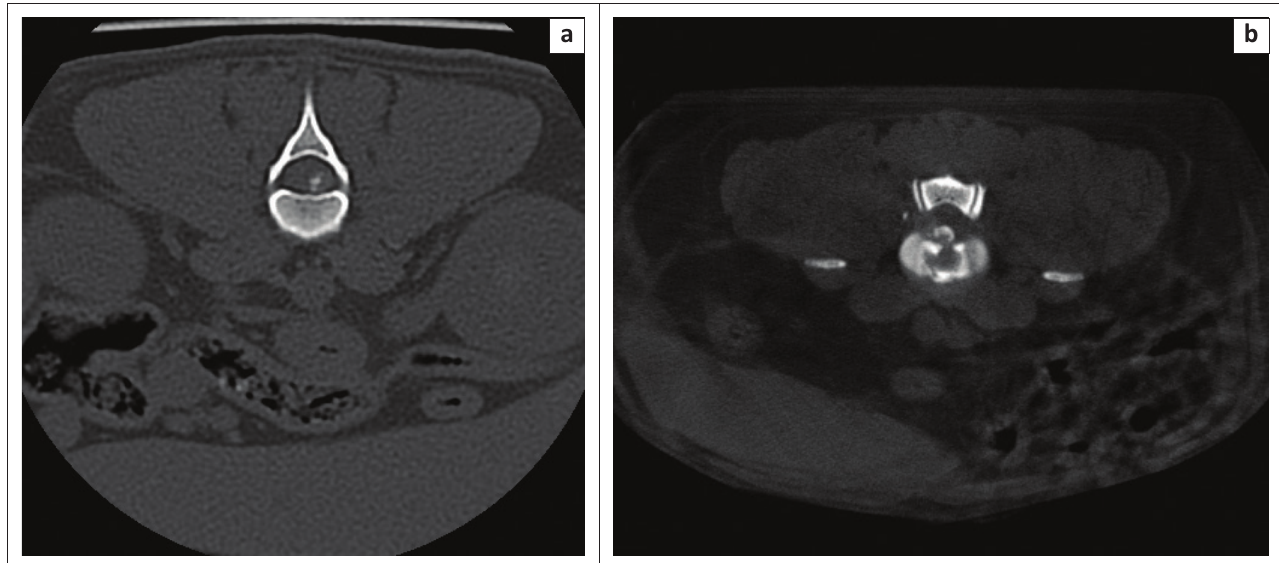
FIGURE 2: Comparative transverse images of an acute intervertebral disc extrusion at the 12th and 13th thoracic vertebrae in a (a) spine window (multi-slice computed tomography) (window width of 2000 and level of 500) and (b) bone window (high-definition volumetric computed tomography) (window width of 1500 and level of 500).